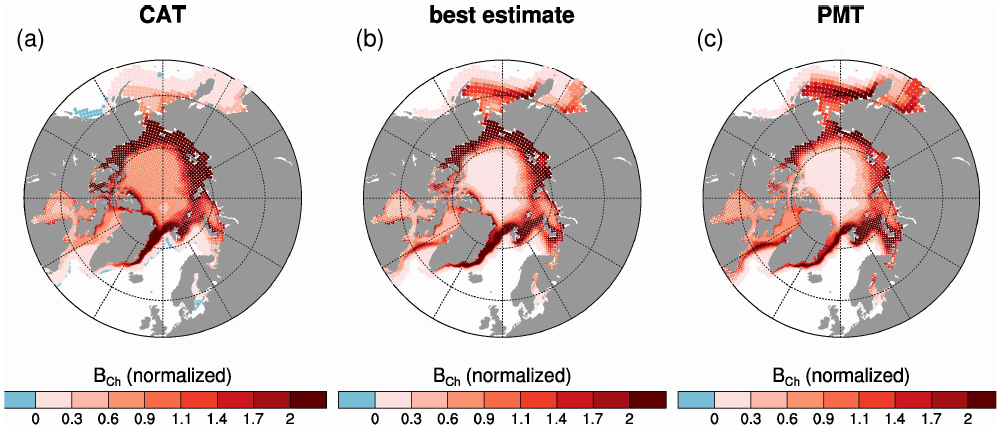
Fig. 8. Scaled diagonal elements of the background model error covariance matrices; (a) derived from Eq. (26) when analysis updates conserve actual thickness; (b) best estimate from a long free model run, and (c) derived from Eq. (27) for proportional mean-thickness analysis updates. The background error covariance implied by analysis updates that conserve mean thickness is zero everywhere. For an interpretation of the figure see main